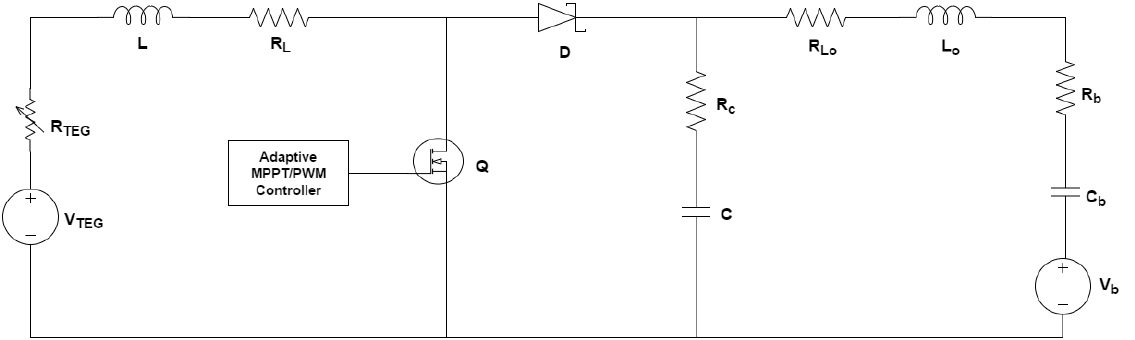
Figure 5. Proposed system circuit